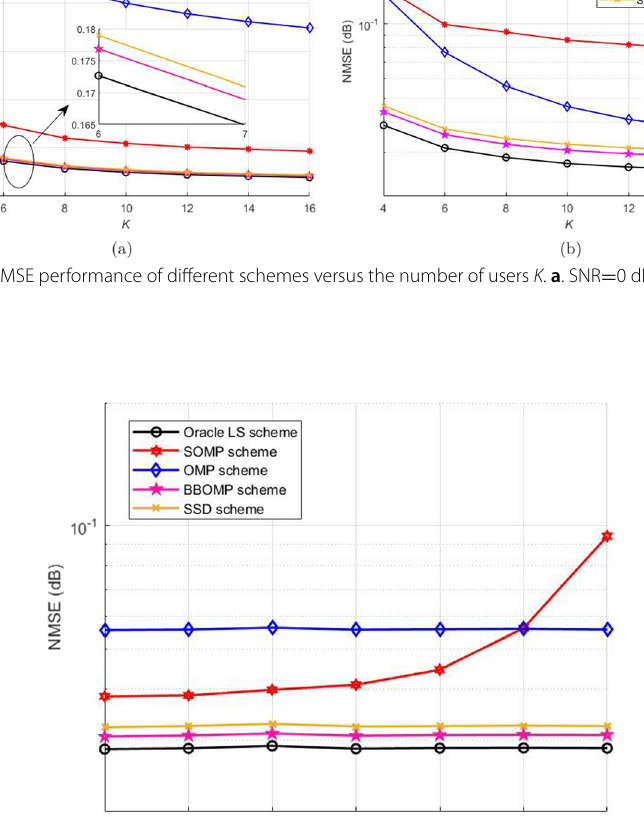
Fig. 6 The NMSE performance of different schemes versus the channel bandwidth